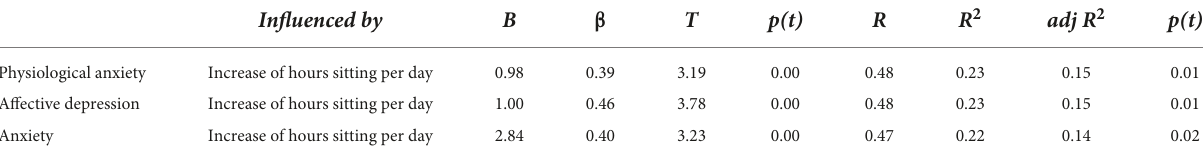
TABLE 5 Prediction of anxiety and depression based on changes in amount of physical activity (PA) due to epidemic for female participants. Influenced by B